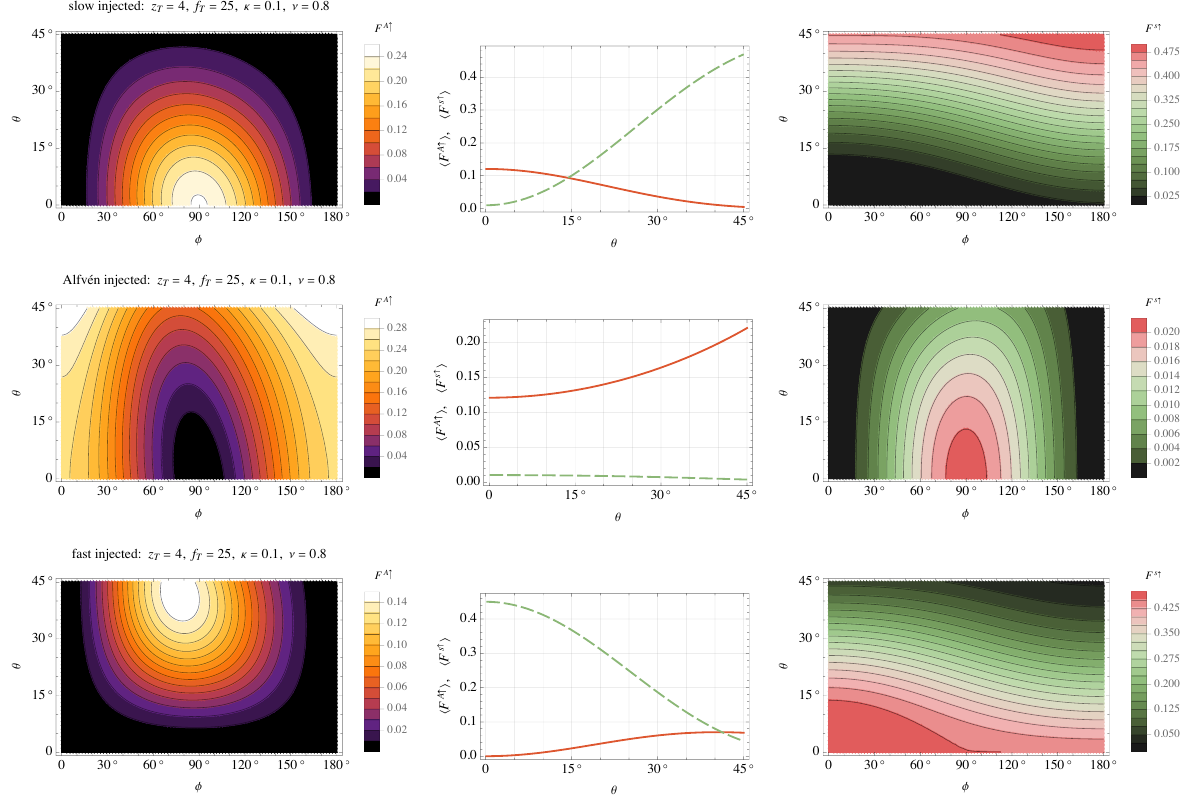
Figure 12. Same as Figure 10, i.e., ν = 0.8, but for f T = 25, which represents a TR of much reduced temperature